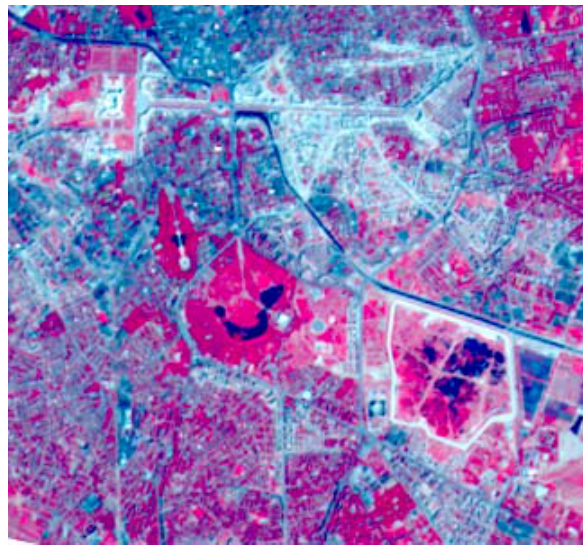
Figure 8. SPOT HRV color composite image of study area The data are usually enhanced after correction. In order to highlight the three classes of spatial features: homogeneous areas, edges (boundaries) and lines, a set of feature extraction